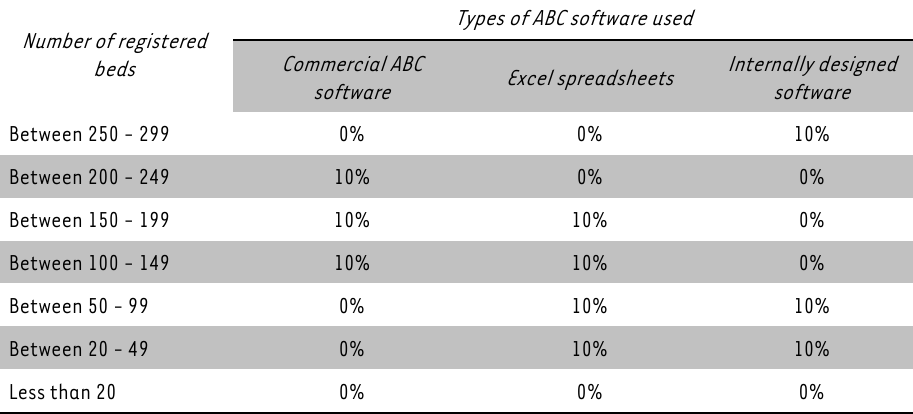
Breakdown of the type of ABC software used in relation to the size of the health care facility in terms of the number of registered